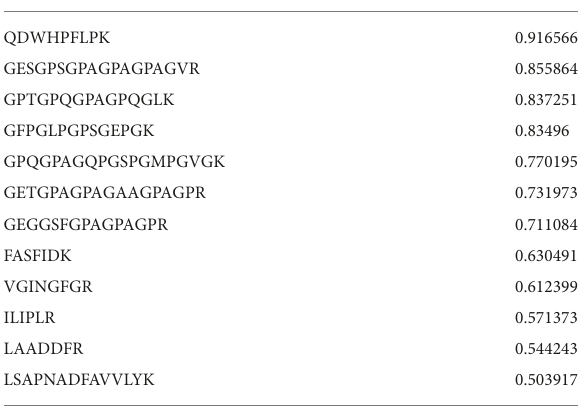
TABLE 3 Activity score results of